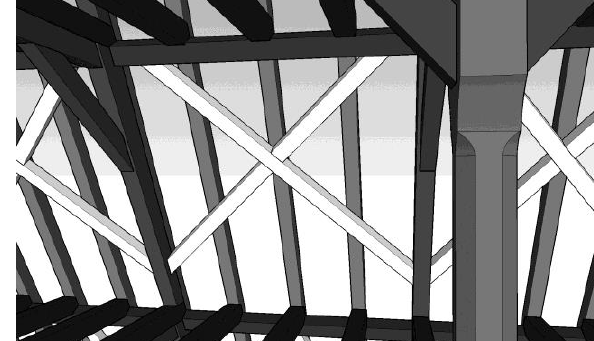
Figure 11: Comparison of view with the actual model